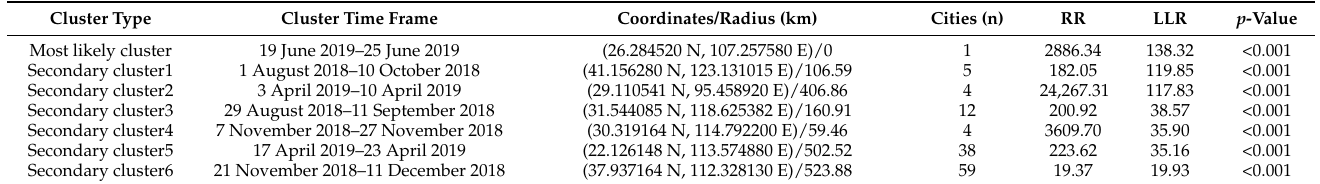
Table 2. Results of the spatiotemporal cluster test on ASF cases at the city level in Mainland China